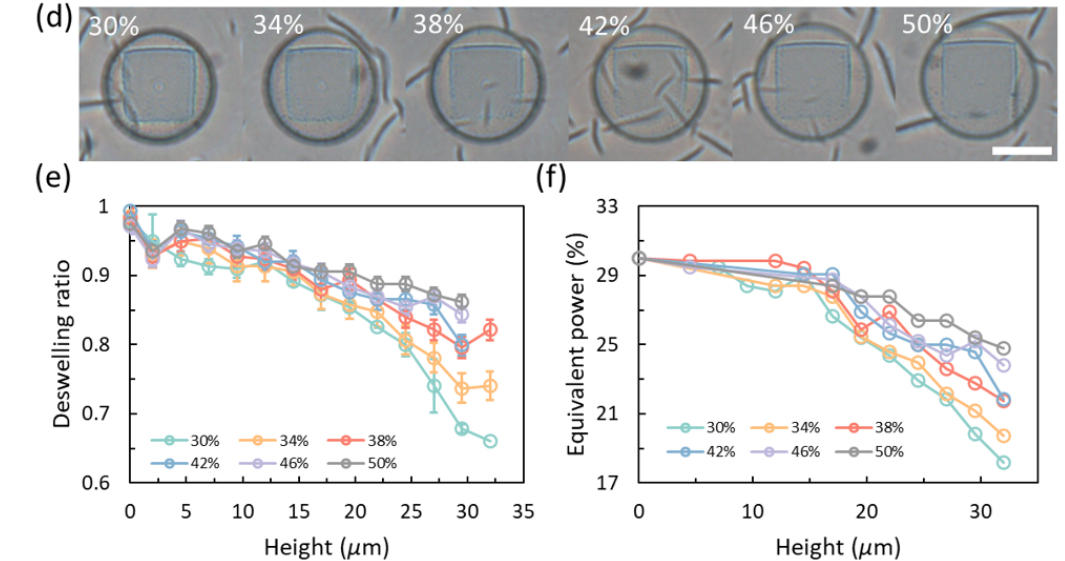
Figure 4. Power decay after penetrating printed layers. ( a ) Power decay along with height for penetrating layers achieved by the same initial laser power of 28%. ( b ) Deswelling data for different initial laser powers. ( c ) Equivalent power converted from the standard prints. ( d ) Power decay of the characterization layer achieved by an identical initial laser power of 30% but with a base printed by different initial powers. ( e ) Deswelling data for different initial laser powers. ( f ) Equivalent power converted from the standard prints. All scale bars: 25 µ